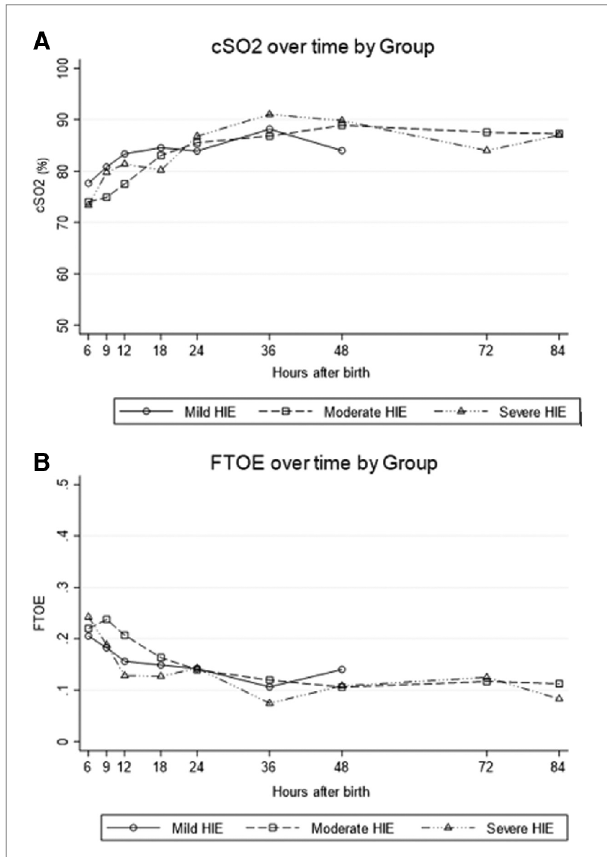
FIGURE 5 For All grades of neonatal encephalopathy, ( A ) cerebral saturation (cSO2) increases over the fi rst 24 h of life and ( B ) cerebral fractional tissue oxygen extraction (FTOE) levels decrease (reproduced with permission from garvey AA, O ’ Toole JM, livingstone V, et al. Evolution of early cerebral NIRS in hypoxic ischemic encephalopathy. Acta Paediatr. 2022;111:1870-77).